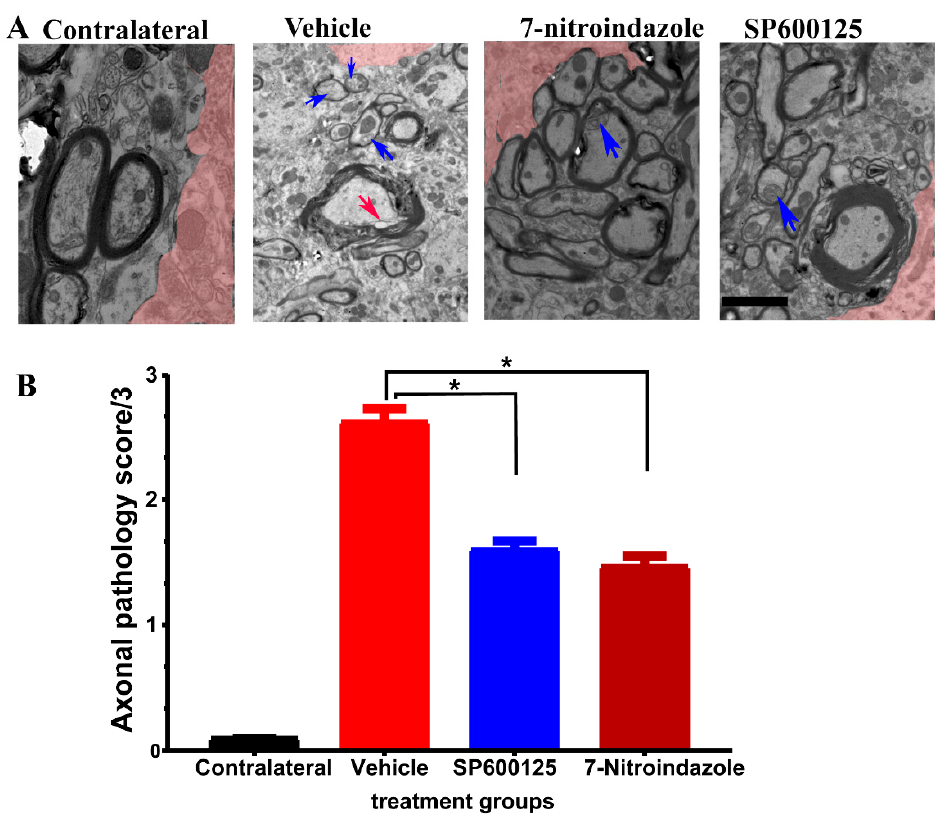
Figure 6. Axonal pathology scores at 6 months after avulsionfollowed by 1 month vehcle and neuroprotective treatment. ( A ) Representative TEM images showing the ultrastructure of axons in the vicinity of α motor neurons. The colorized part is the α motor neurons. ( B ) Axonal pathology scores. Values are expressed as the mean ± SD. Comparisons between vehicle and treatment groups were by One-way ANOVA whereby * denotes p < 0.05. The red arrow shows vacuole while blue arrows depict disintegration and edema.